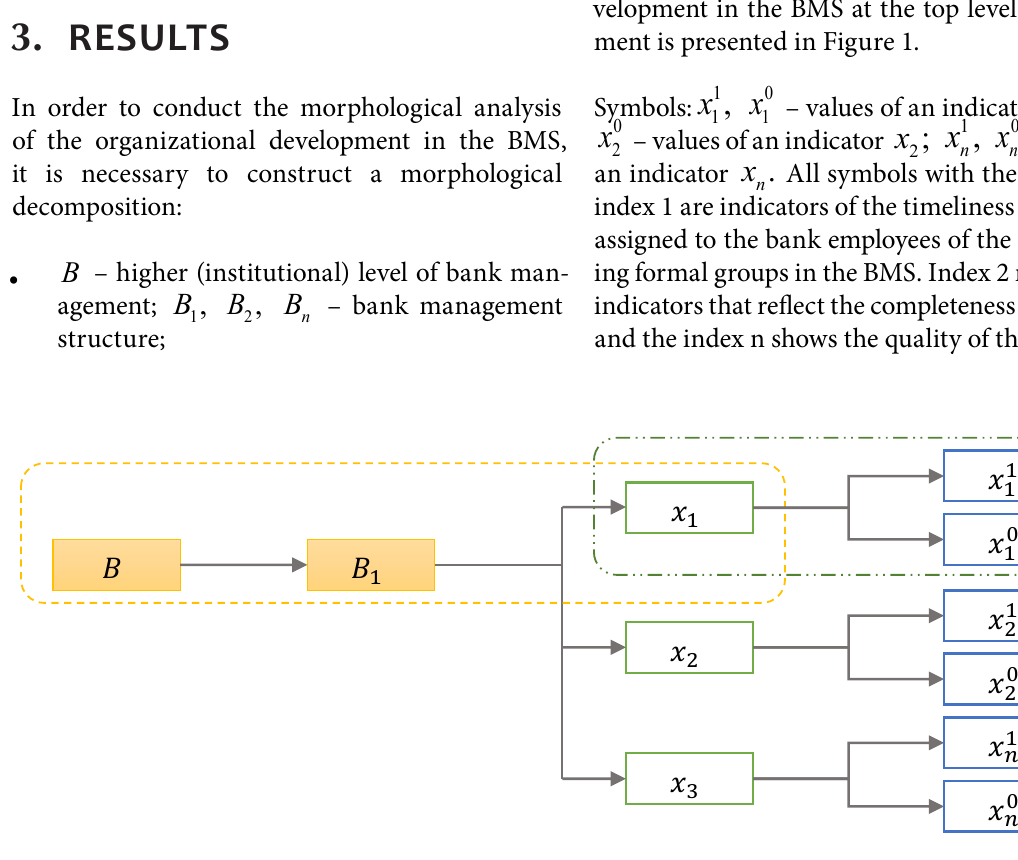
Figure 1. The fragment of the morphological